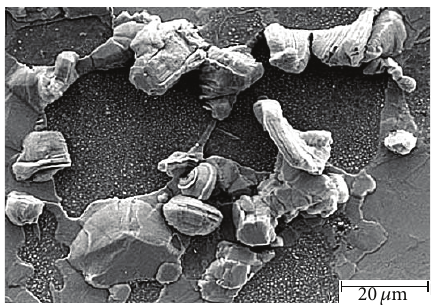
Figure 12: SME image of Sn whisker shorting two legs [97].